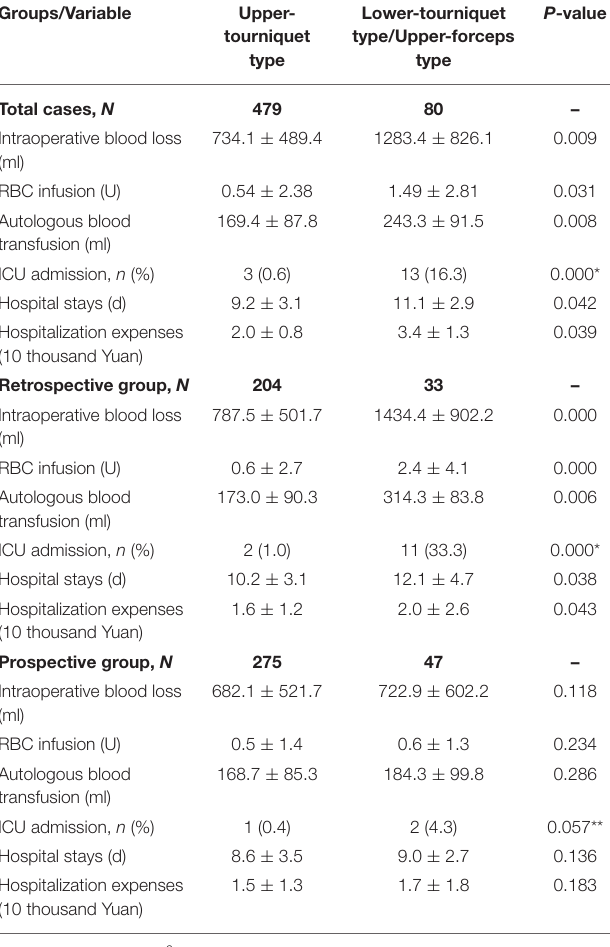
TABLE 3 | Comparison of different types of perioperative indicators. Groups/Variable